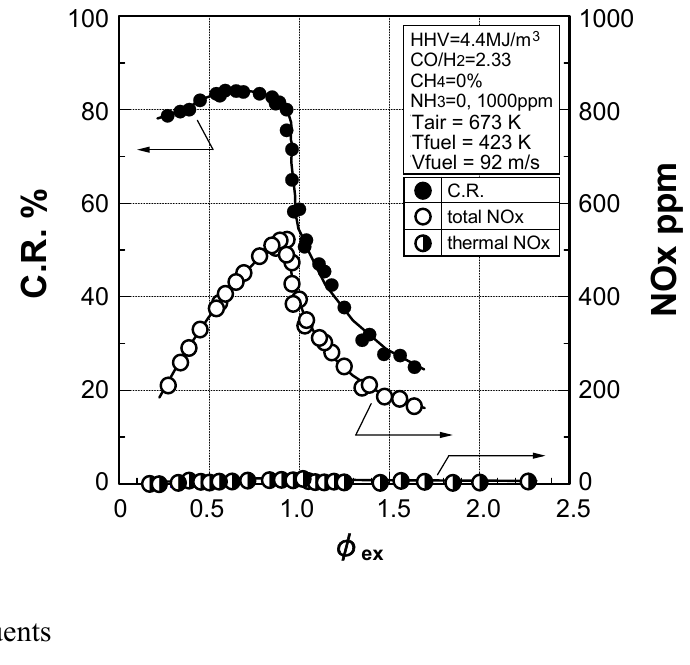
Figure 11. NOx emissions characteristics in low-Btu fueled